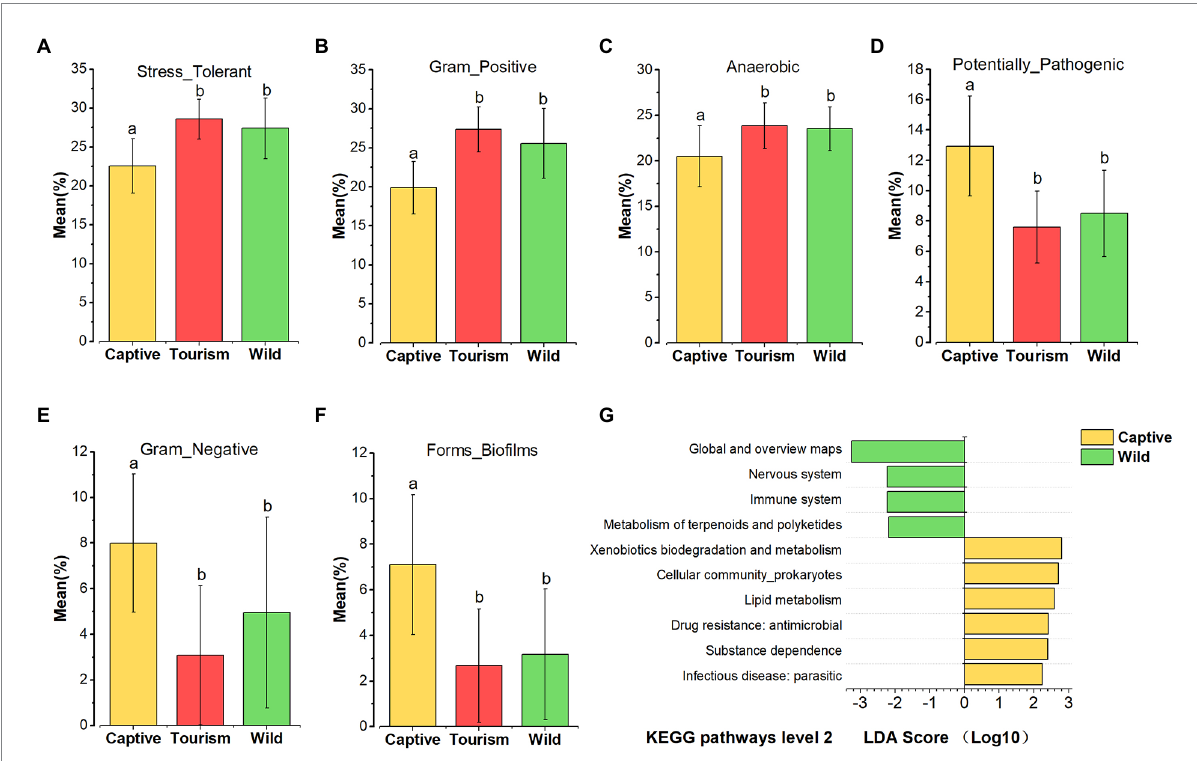
FIGURE 6 Variation in phenotypic properties and KEGG pathways of gut microbiome among different groups. (A–F) : Comparison of the phenotypic properties of Stress Tolerant, Gram Positive, Anaerobic, Potentially Pathogenic, Gram Negative and Forms Biofilms, respectively. A Kruskal-Wallis test was used to evaluate the variation across study groups. Post-hoc tests (Tukey–Kramer test) for pairwise comparison tests ( p values were adjusted by Bonferroni). Significance was set at the 0.05 level. G : KEGG pathways at level 2. Indicators identified by linear discriminant analysis effect size (LEfSe) analysis, LDA > 2, p <